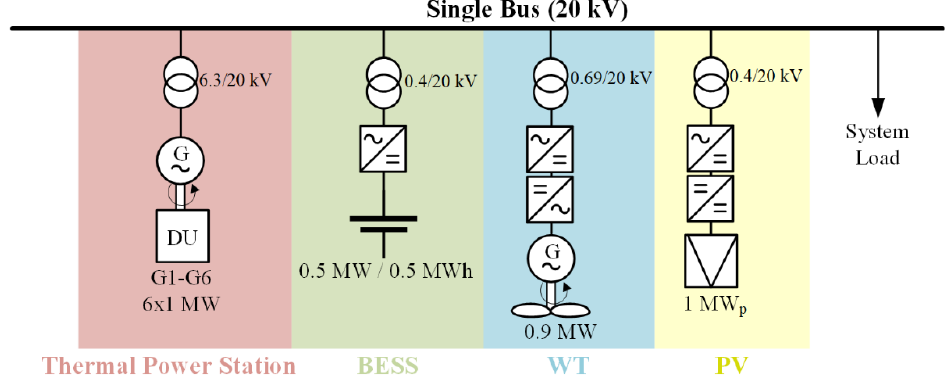
Figure 6. Study case autonomous system.